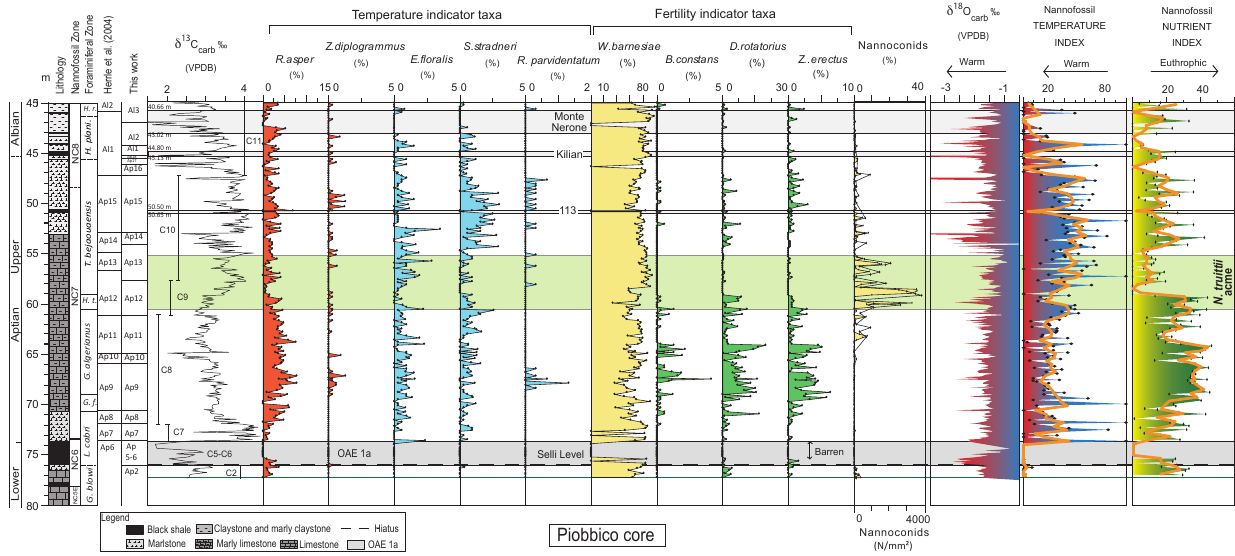
Figure 4. Piobbico core: fluctuations of calcareous nannofossil temperature and fertility indicator taxa. Temperature (TI) and nutrient (NI) indices based on calcareous nannofossils (low values of the TI indicate high temperatures and vice versa; high values of the NI indicate high surface-water productivity and vice versa). The orange curve indicates smoothed TI and NI records based on three-point moving average. δ 13 C is from Erba et al. (2015). Nannofossil and foraminiferal biostratigraphy is from Erba (1988) and Tornaghi et al. (1989). Bulk δ 18 O data are from this